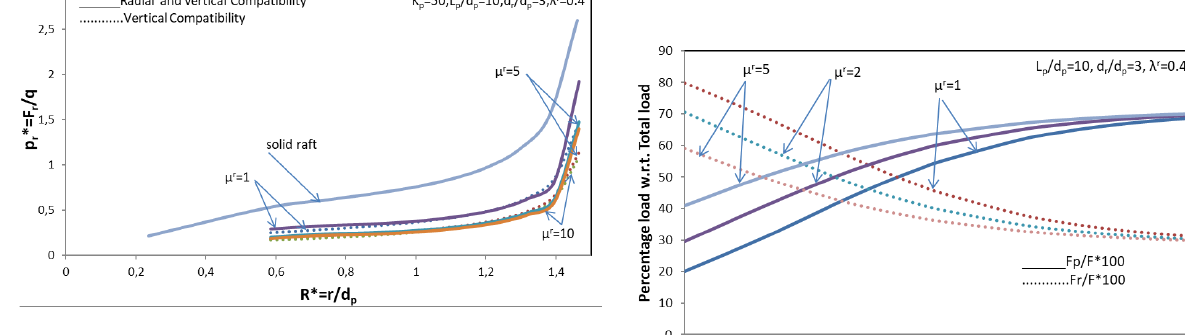
, of GP and comparative size of raft, d p